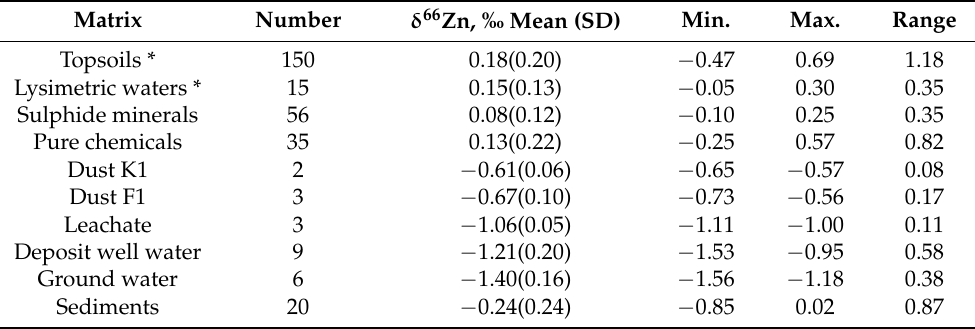
Table 4. Zinc isotopic composition in environmental, geological, and industrial samples. Matrices marked * reported from previous studies [22].